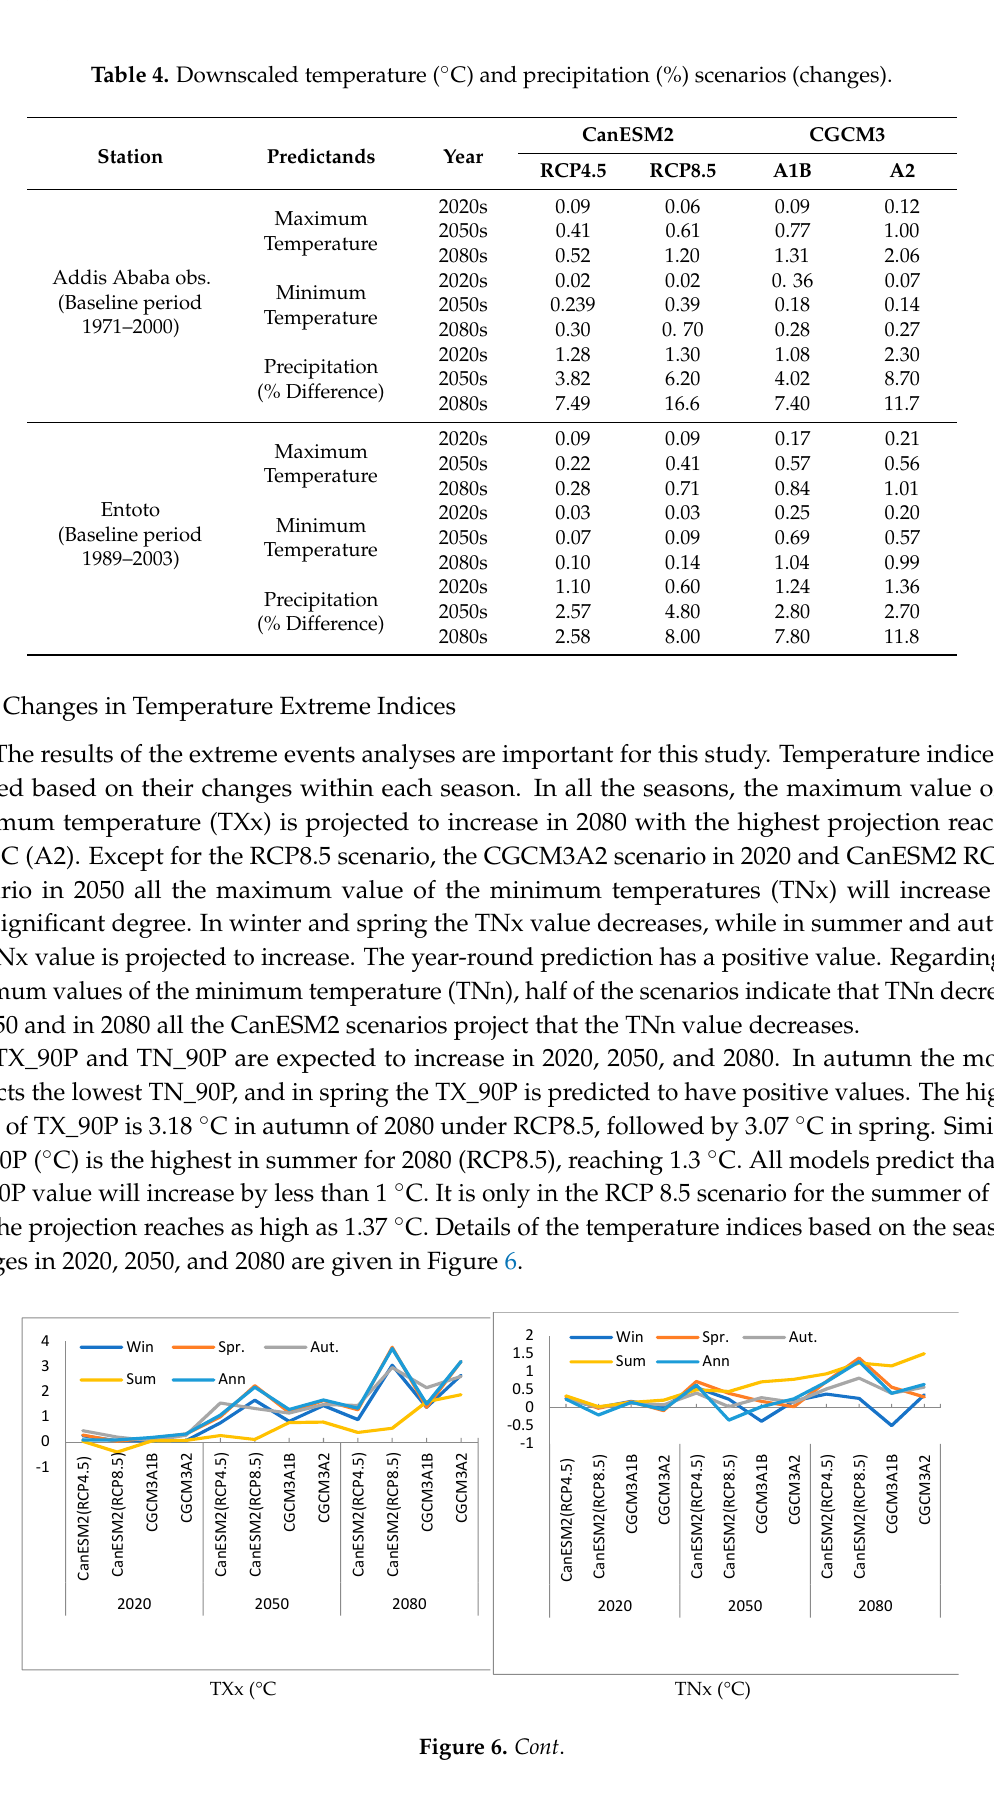
Table 4. Downscaled temperature ( ◦ C) and precipitation (%) scenarios (changes).